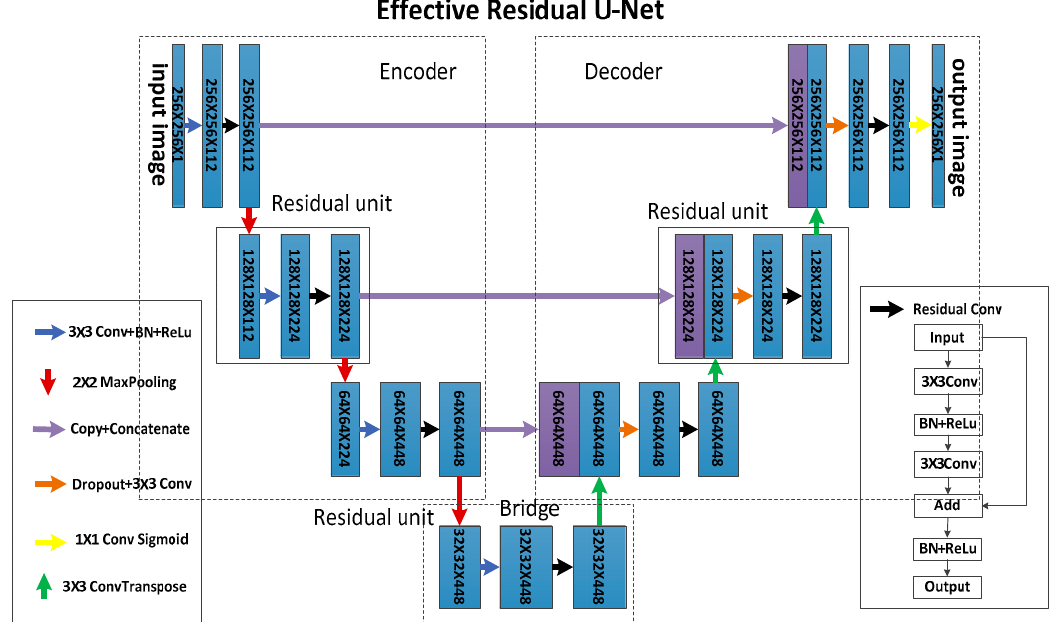
Figure 2. ERU-Net (effective residual U-Net) structure (the number of initial filters: 112, input image size: 256 × 256 × 1).